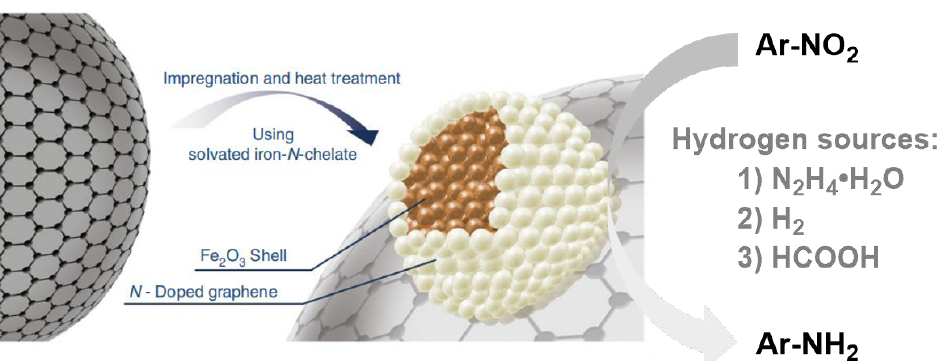
Figure 11. Schematic diagram of Fe-phen/C preparation and its catalyzed reduction reaction of nitroaromatics. Reprinted with permission from Ref. [42]. Copyright 2015, American Chemical Society.